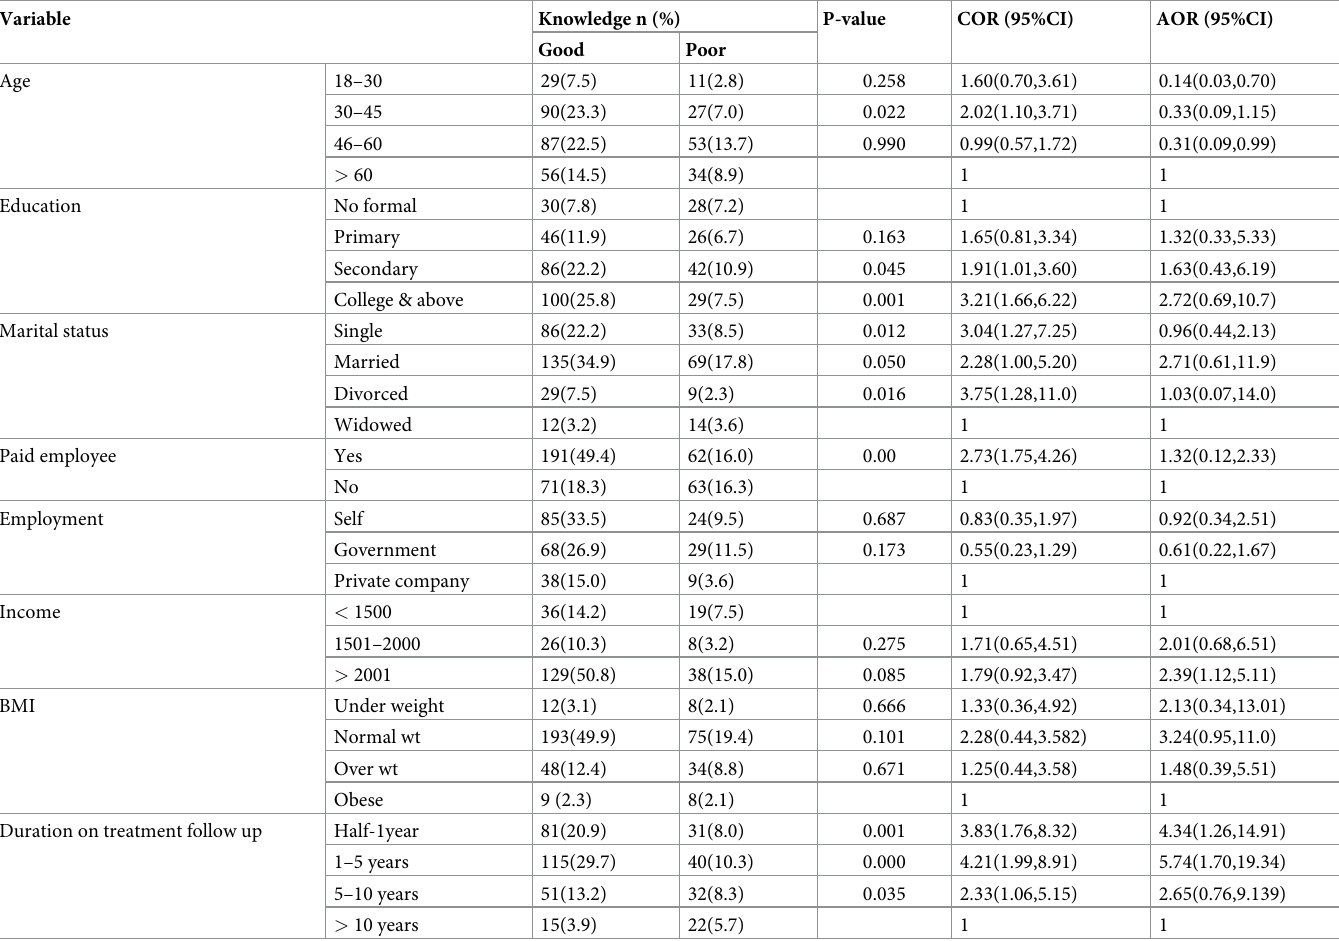
Table 7. Factor independently associated with knowledge of hypertensive patients on treatment follow up regarding lifestyle modification at Yekatit 12 General hospital in 2019 (n = 387).